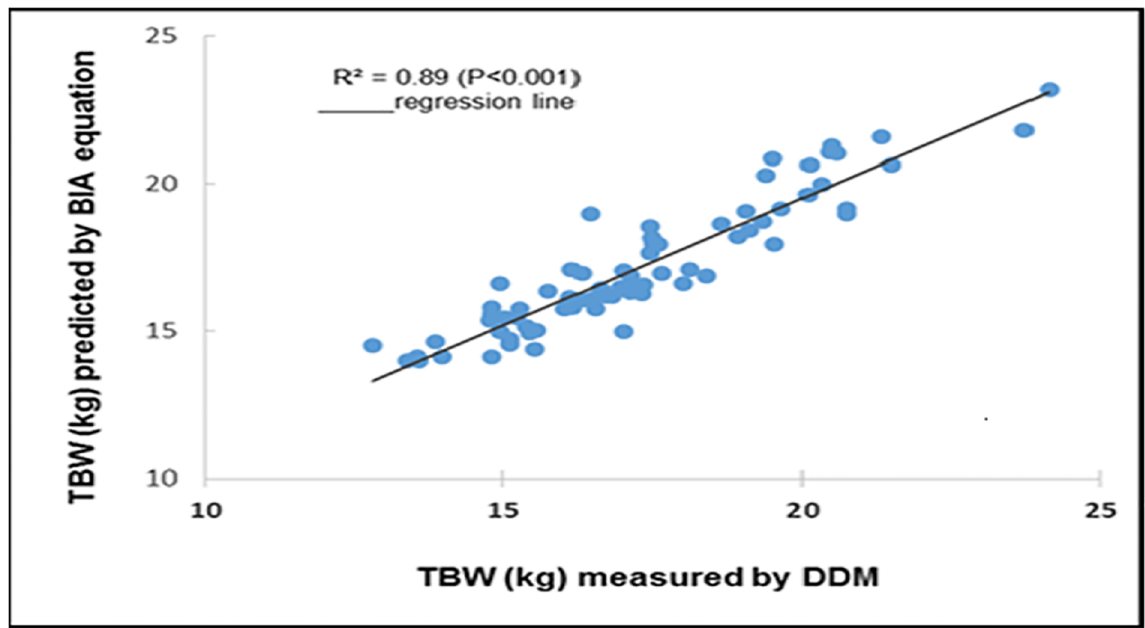
Fig 1. Correlations plot between TBW values from DDM and BIA were performed and r value measure the degree of linear connection between two variables.